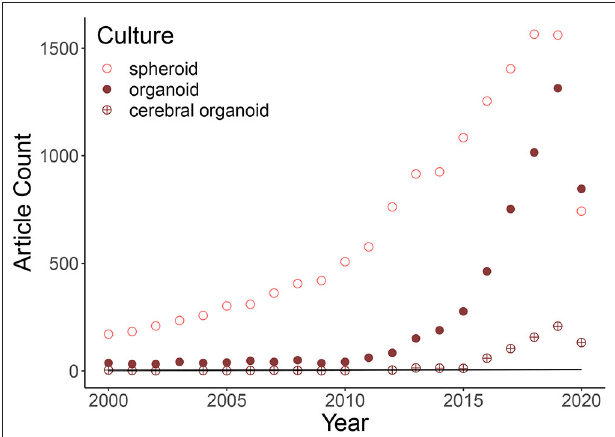
FIGURE 1 | Graphic representation of the soaring of three-dimensional cultures based on a pubmed search of the following keywords: “spheroid,” “organoid,” and “cerebral organoid.” Cerebral organoid articles are a subset of the keyword “organoid” research. The expanding of published articles is explained by an exponential model at 89% (Rsquared: 0.8876: Growth Model = log(Count) Year:Culture). The first generation of cerebral organoids was in 2013, so the previous few articles identified by pubmed contain the two keywords but do not talk about these 3D brain cultures inside the body of the text. The points in 2020 are not on the curves due to the fact that the year is not over.